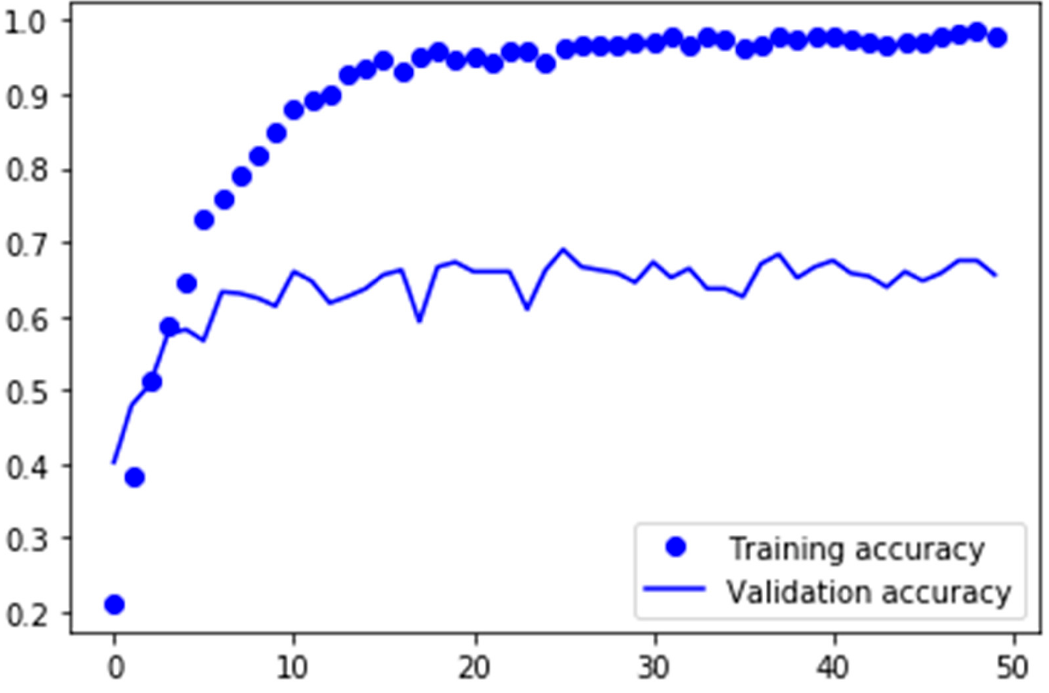
Figure 13. Training and validation accuracy without data preprocessing, trained over 50 epochs. Figure 14 plots the training and validation accuracy of exactly the same model, with the only difference being that the input data was preprocessed with data augmentation. By just enlarging the dataset with fake data, the problem of overfitting vanished, and at the same time, the validation accuracy improved from 71.04% to